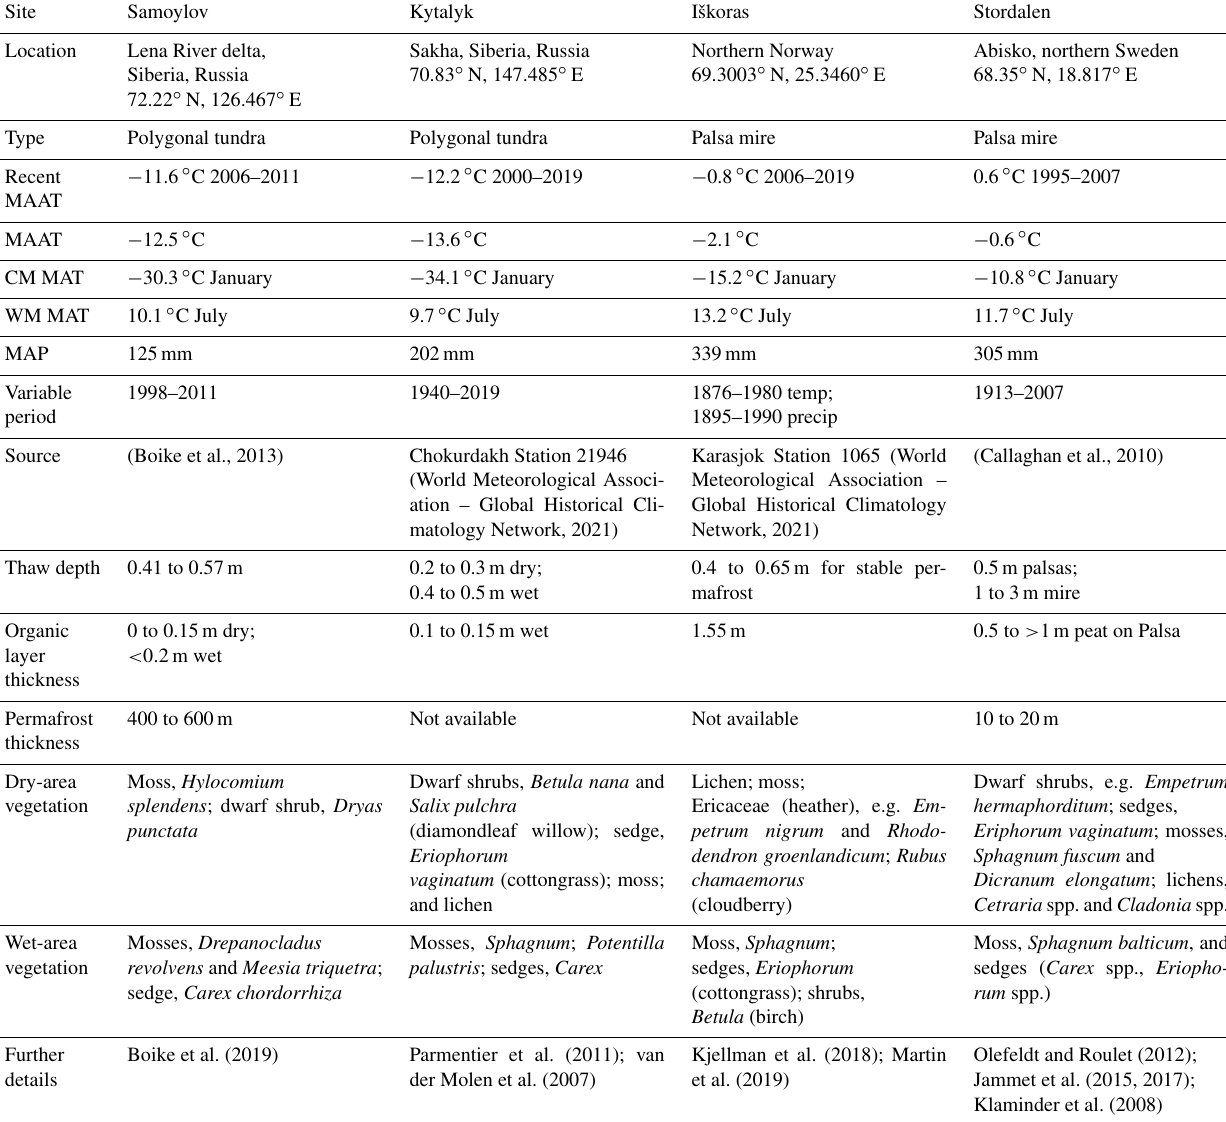
Table A1. Further site information. Acronyms are defined as follows: MAAT stands for mean annual air temperature, MAP stands for mean annual precipitation, WM stands for warmest month, and CM stands for coolest month. Other than “recent MAAT”, climatic variables are aggregated for the period given by “variable